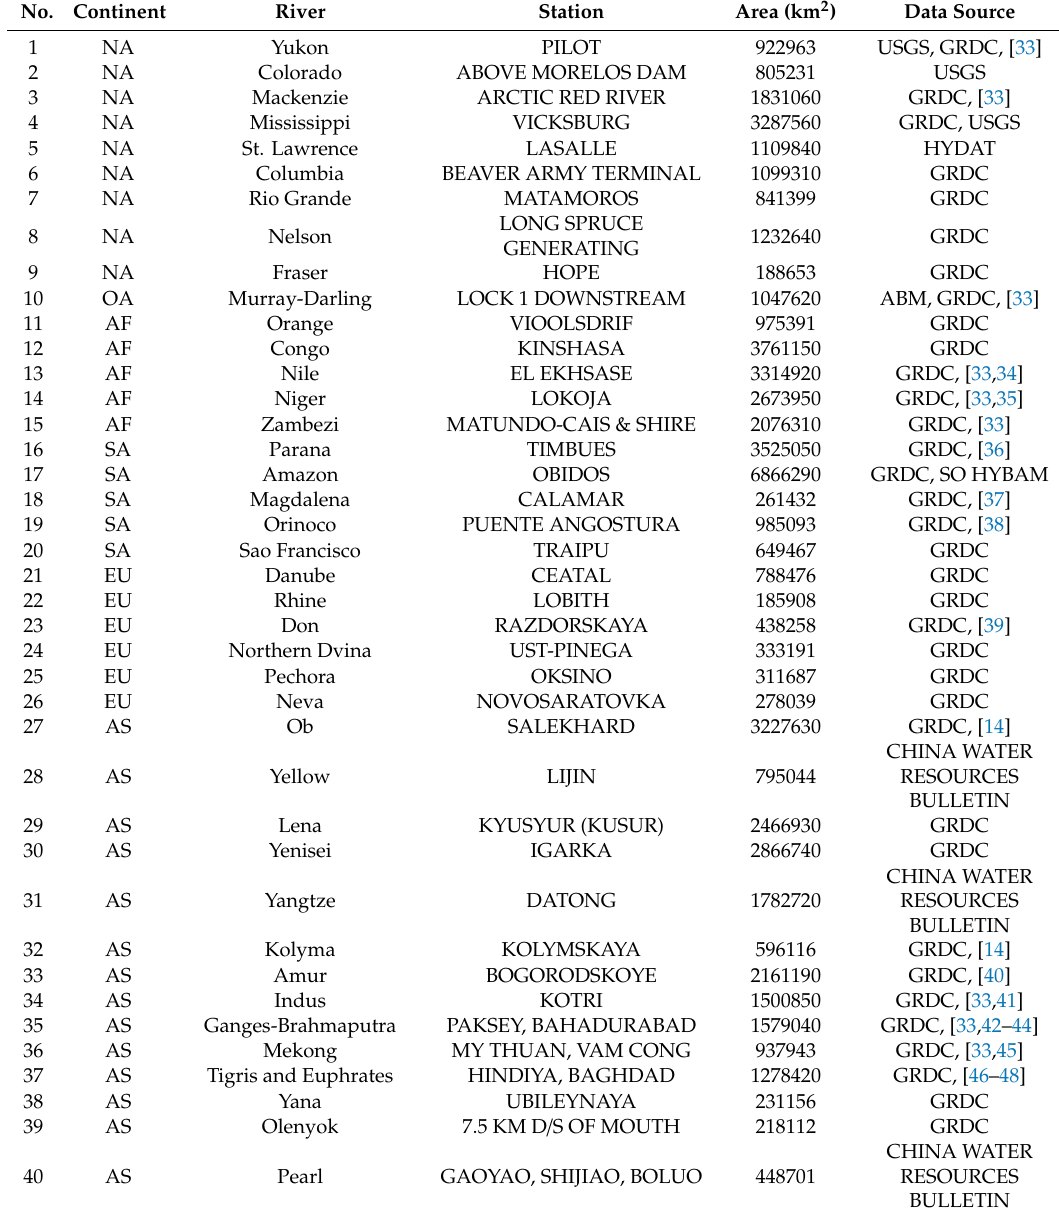
Table 1. River information and data